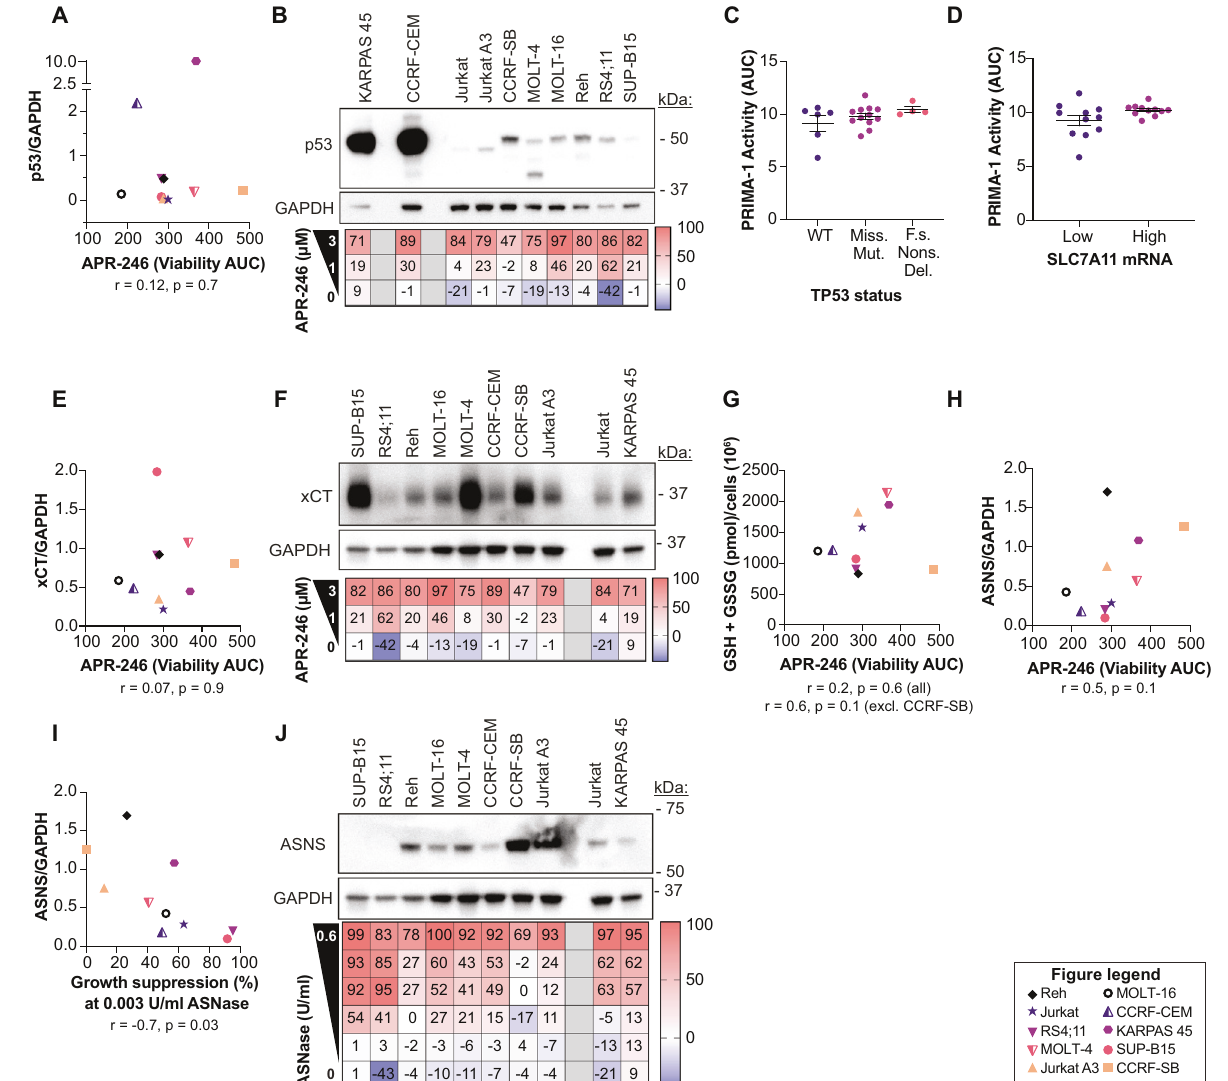
r = 0.5, p = 0.1 r = 0.6, p = 0.1 (excl. CCRF-SB)